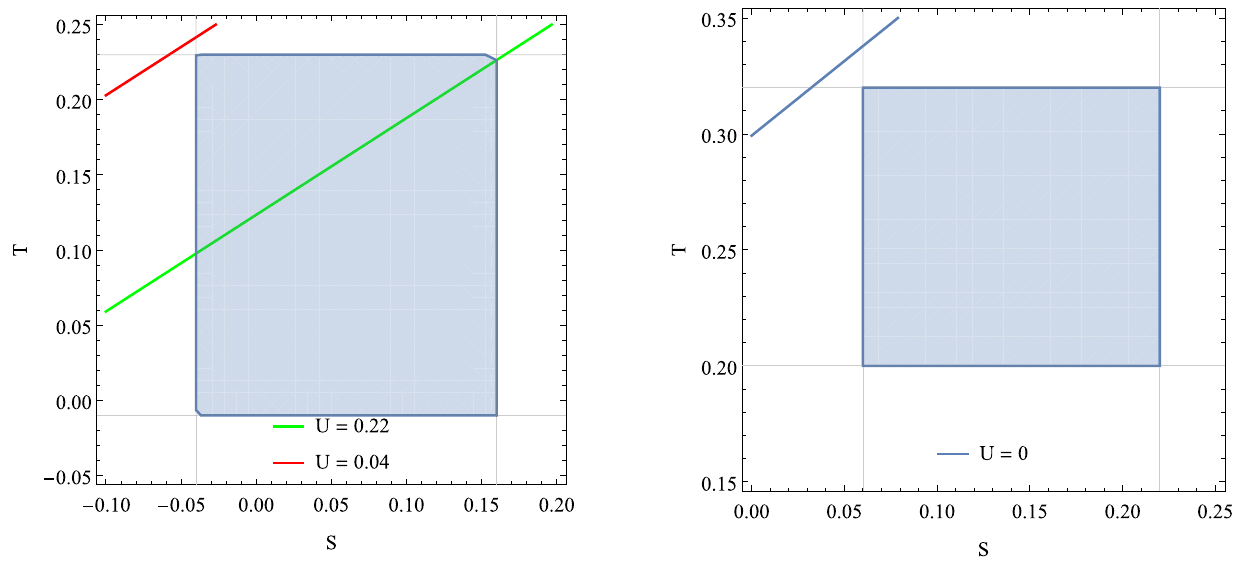
Fig. 8 Left: Solution for S, T parameters with fixed parameter U, where the blue shaded region covers the bounds, as obtained by fit taking into account the new mass of W boson. Right: No solutions found when U is